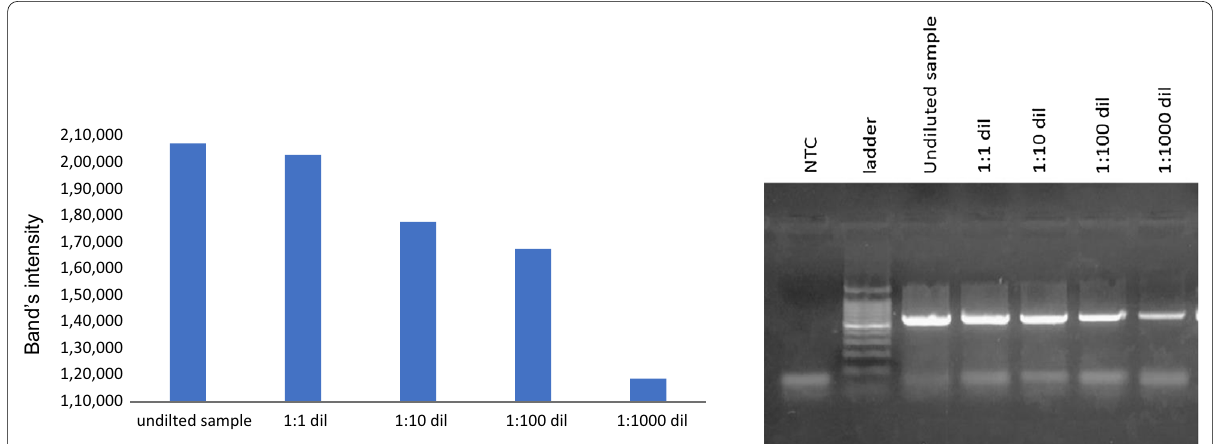
Fig. 4 RT-PCR of N-450 using MeV210 and MeV217 primers for RNA purified with our homemade kit solutions and carrier. The RT-PCR was done for RNA extracted after serial dilution of infected Vero cells. Amplicons with 626 bp were detected by 2% agarose gel electrophoresis. 50 bp generuler ladder (thermoscientific) was used as standard